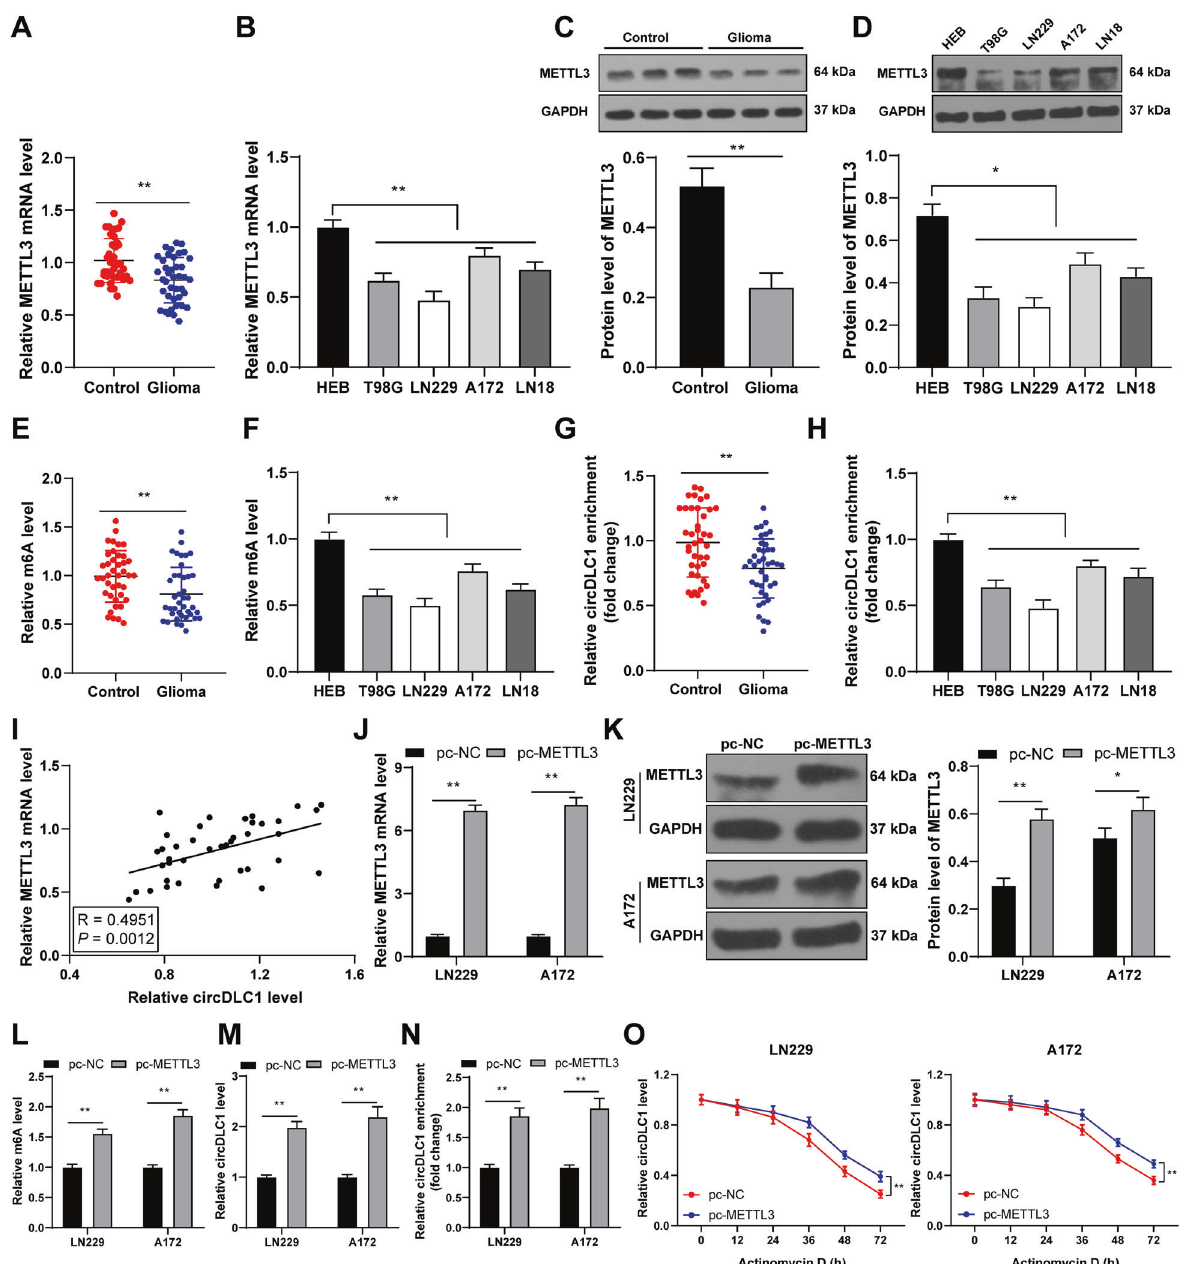
Fig. 3 METTL3-mediated m 6 A modi fi cation enhanced circDLC1 stability and upregulated circDLC1 expression. A – D METTL3 expression in glioma tissues and cells was detected using RT-qPCR and western blot. E , F m 6 A quantitative analysis of m 6 A level in tumor tissues and cells. G , H MeRIP analysis of m 6 A level of circDLC1 in tumor tissues and cells. I Pearson correlation analysis of the correlation between METTL3 and circDLC1 in 40 cases of glioma. METTL3 pcDNA 3.1 (pc-METTL3) was transfected into LN229 and A172 cells, respectively, with NC pcDNA 3.1 (pc-NC) as NC. J , K METTL3 expression in cells was detected using RT-qPCR and western blot. L m 6 A quantitative analysis of m 6 A level in cells. M circDLC1 expression in cells was detected using RT-qPCR. N MeRIP analysis of m 6 A level of circDLC1 in cells. O After actinomycin D treatment, circDLC1 expression in cells was detected using RT-qPCR. N = 40. The cell experiment was repeated three times independently. Data in panels B – D / F / H / J – O are presented as mean ± standard deviation. The comparisons between two groups in panels A / E / G were analyzed using paired t -test, and the comparisons between two groups in panels C / J – N were analyzed using t -test. The comparisons among multiple groups in panels B / D / F / H were analyzed using one-way ANOVA, and the comparisons among multiple groups in panel O were analyzed using two-way ANOVA, followed by Tukey ’ s multiple comparisons test, * p < 0.05, ** p < 0.01. transfected into LN229 cells, CTNNBIP1 mRNA expression in CTNNBIP1 silencing attenuated the inhibitory effect of LN229 cells was decreased ( p < 0.01, Fig. 6A). We chose si- circDLC1 overexpression on malignant proliferation of glioma CTNNBIP1#2 and pc-circDLC1 to treat LN229 cells. Also, we cells transfected CTNNBIP1 pcDNA 3.1 (pc-CTNNBIP1) into A172 cells Then, we veri fi ed the regulatory effect of CTNNBIP1 on glioma (p < 0.01, Fig. 6A), and then, pc-CTNNBIP1-treated A172 cells cells. After three CTNNBIP1 siRNAs (si-CTNNBIP1) were